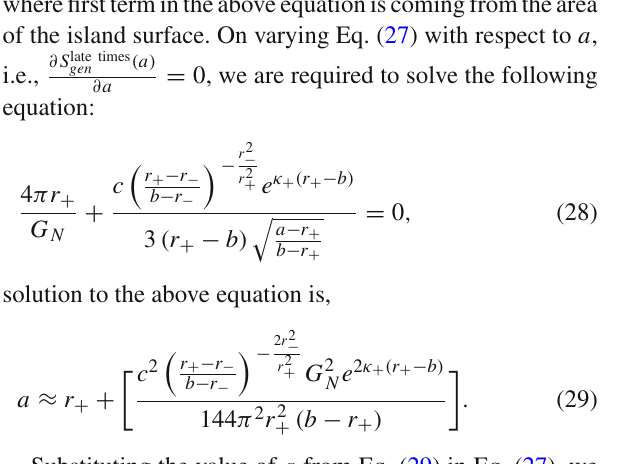
Fig. 4, blue line corresponds to the linear time growth of the entanglement entropy (Eq. (24)) and orange line corresponds to the entanglement entropy in the presence of island surface (Eq. (30)) which dominates after the Page time and leads to the Page